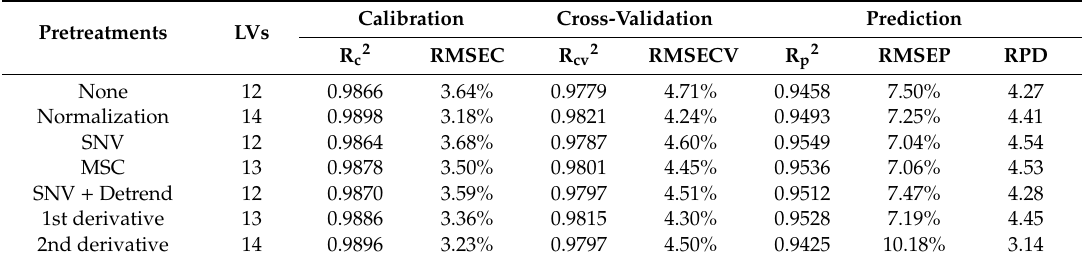
Table 1. Performance of partial least square regression (PLSR) models for predicting minced jowl meat adulterated in